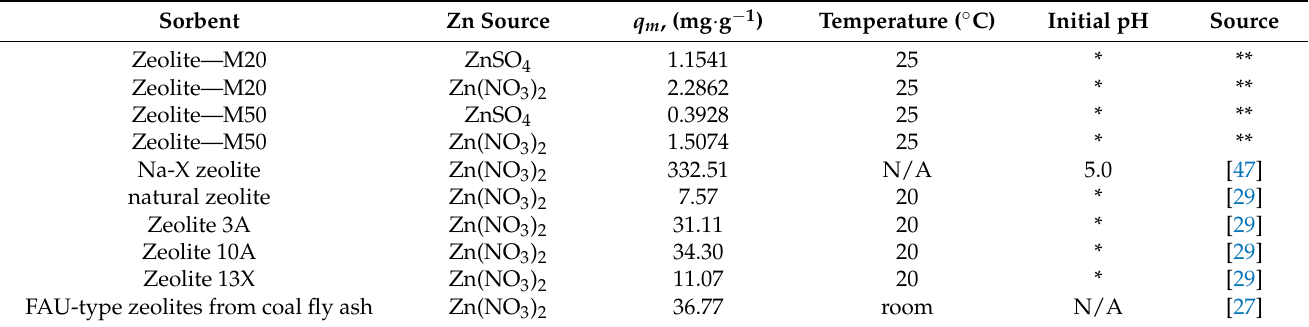
Table 11. A comparison of sorption capacities of different Zn